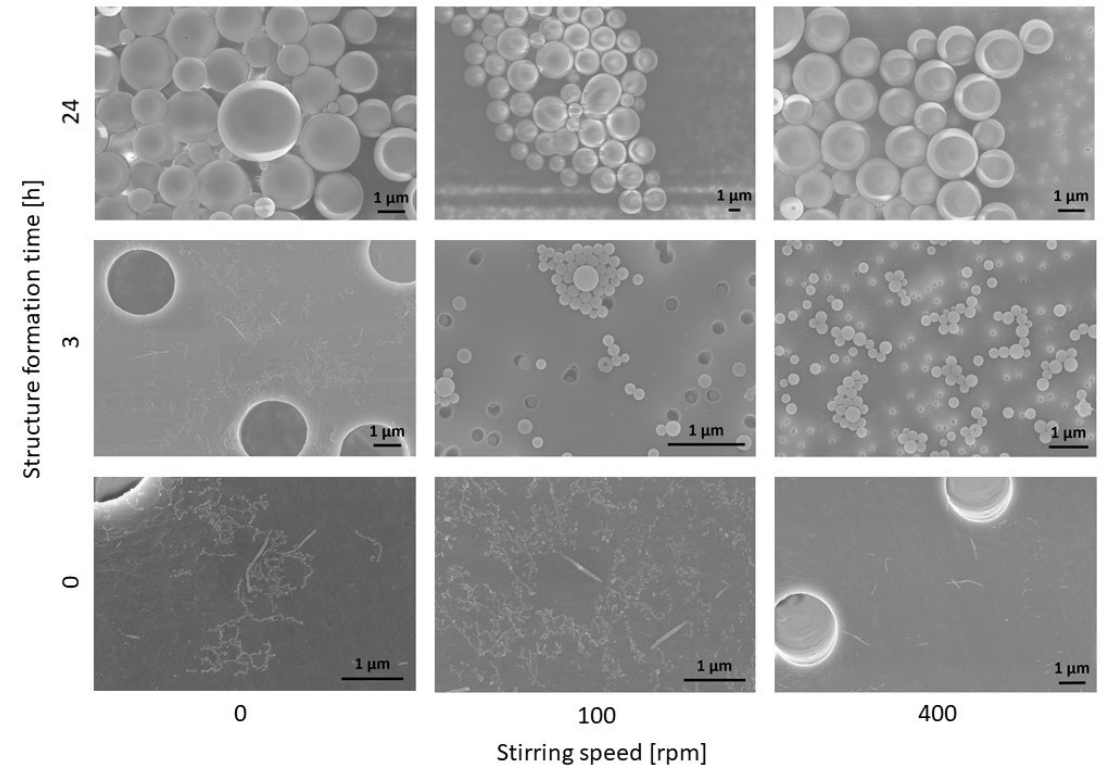
Figure 8. Representative SEM images of the morphologies of the polymer structures as a function of the structure formation time and the stirring speed.